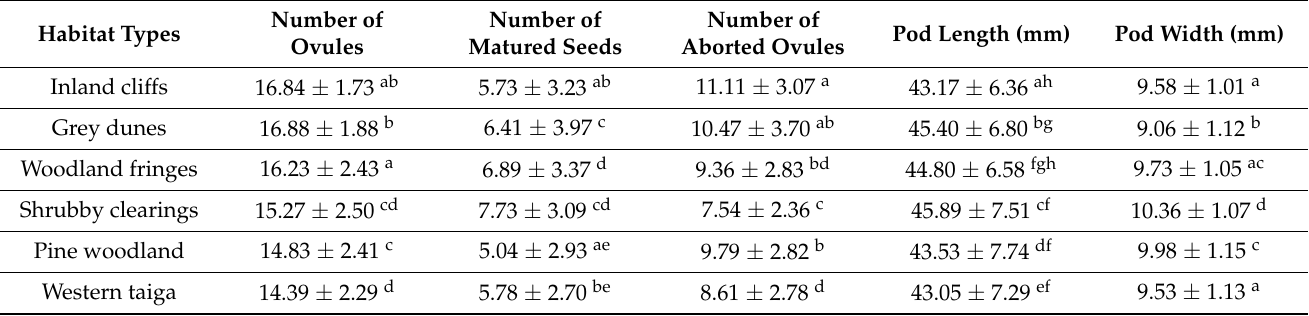
Table A7. Mean values and standard deviations of reproductive traits of Cytisus scoparius in the sites grouped by habitat type (n = 200 in each). Different letters indicate statistically significant differences of the trait mean values between habitat types according to the Tukey’s post-hoc pairwise